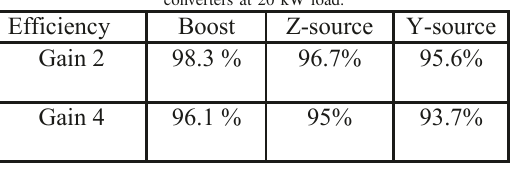
TABLE VII. Comparison of the total efficiencies using gain 2 and gain 4 for the converters at 20 kW